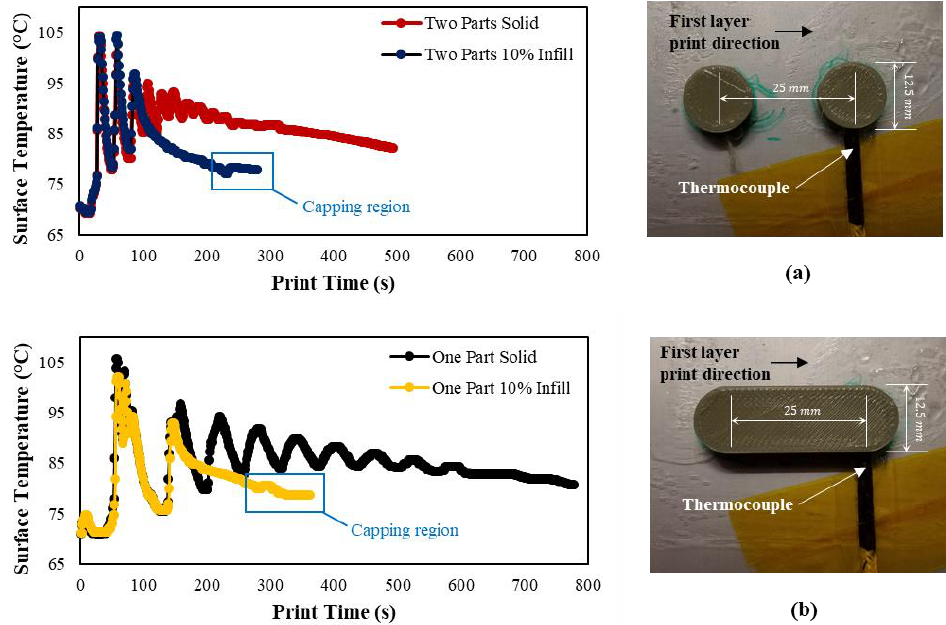
Figure 23. Part-plate interface temperature test results for the ( a ) double and ( b ) single part cases.